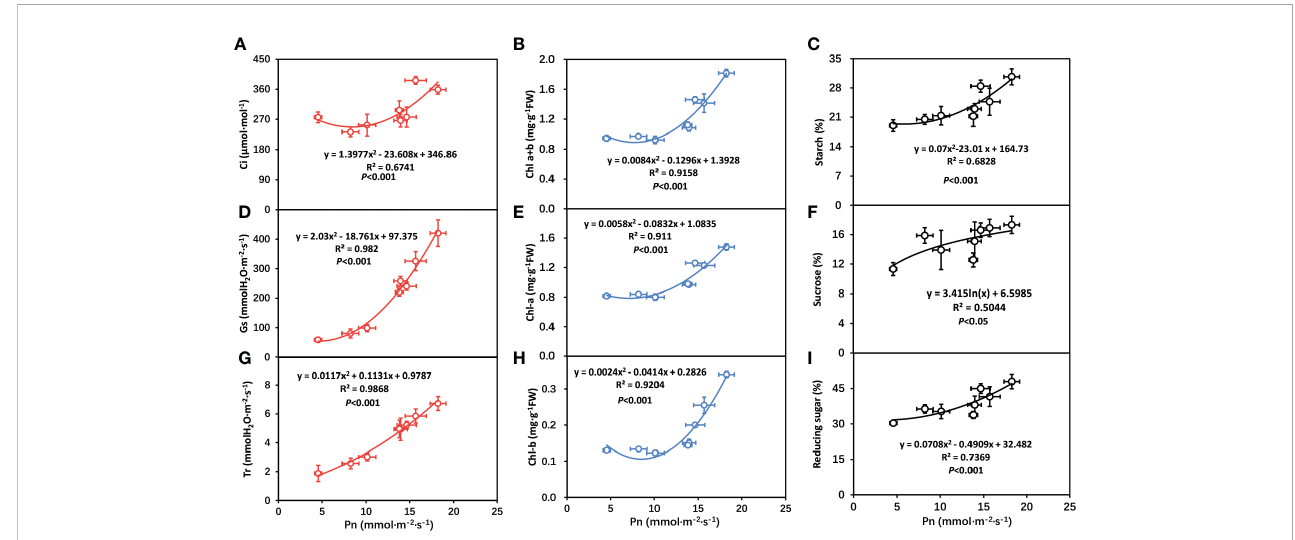
FIGURE 7 Correlation analysis of photosynthetic rate with gas exchange parameters in tobacco plants. (A) correlation between intercellular carbon dioxide concentration (Ci) and net photosynthetic rate (Pn); (B) correlation between total chlorophyll contents ( Chl-a+b ) and net photosynthetic rate (Pn); (C) correlation between starch and net photosynthetic rate (Pn); (D) correlation between stomatal conductance (Gs) and net photosynthetic rate (Pn); (E) correlation between chlorophyll-a contents ( Chl-a ) and net photosynthetic rate (Pn); (F) correlation between sucrose and net photosynthetic rate (Pn); (G) correlation between transpiration rate (Tr) and net photosynthetic rate (Pn); (H) correlation between chlorophyll-b contents ( Chl-b ) and net photosynthetic rate (Pn); (I) correlation between reducing sugar and net photosynthetic rate (Pn). The statistically signi fi cant mean differences among various treatments were identi fi ed by using Duncan ’ s test at a signi fi cance level of